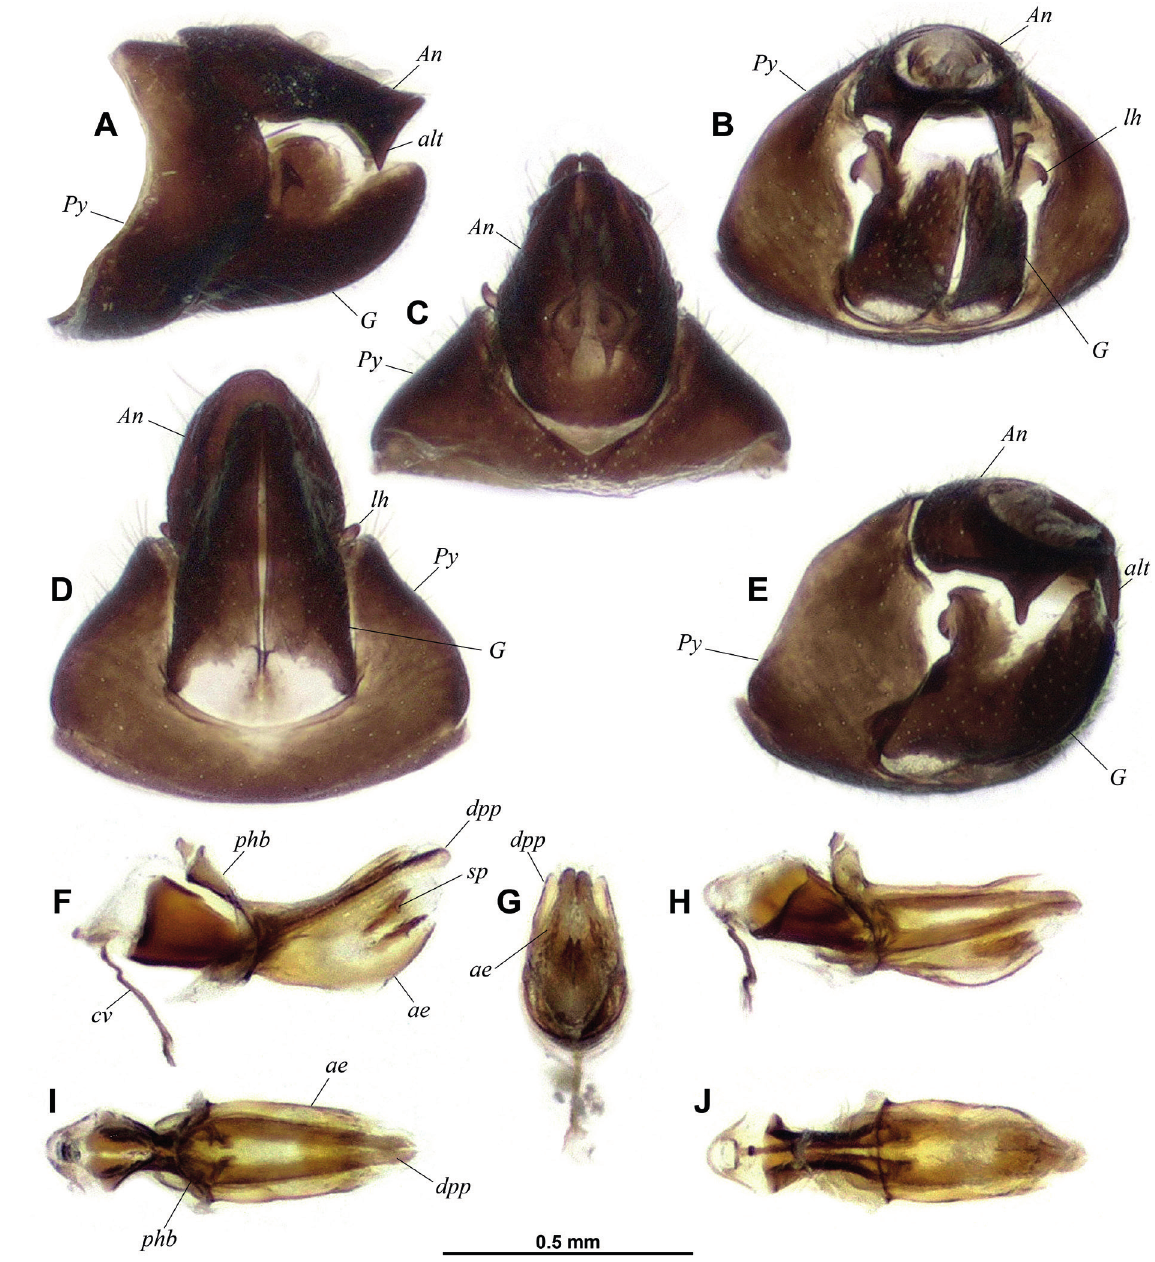
Fig. 4. Cleotyche ( Cleotyche ) christinae sp. nov., ♂, holotype (QM). A–E . Pygofer, anal tube and gonostyli. A . Left lateral view. B . Caudal view. C . Dorsal view. D . Ventral view. E . Laterocaudal view. F–J . Aedeagus. F . Left lateral view. G . Caudal view. H . Dorsolateral view. I . Dorsal view. J . Ventral view. Abbreviations: ae = aedeagus; alt = apicolateral tooth of anal tube; An = anal tube; cv = connective; dpp = dorsal process of phallobase; G = gonostylus; lh = lateral hook of gonostylus; phb = phallobase; Py = pygofer; sp = spine of